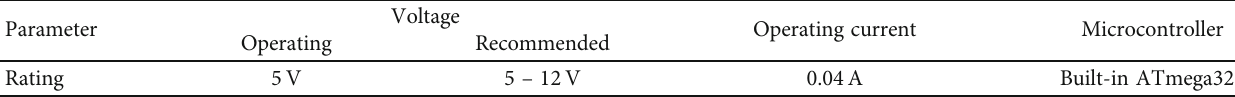
Figure 5: CBR algorithm. Table 4: Speci fi cations of Arduino Uno.